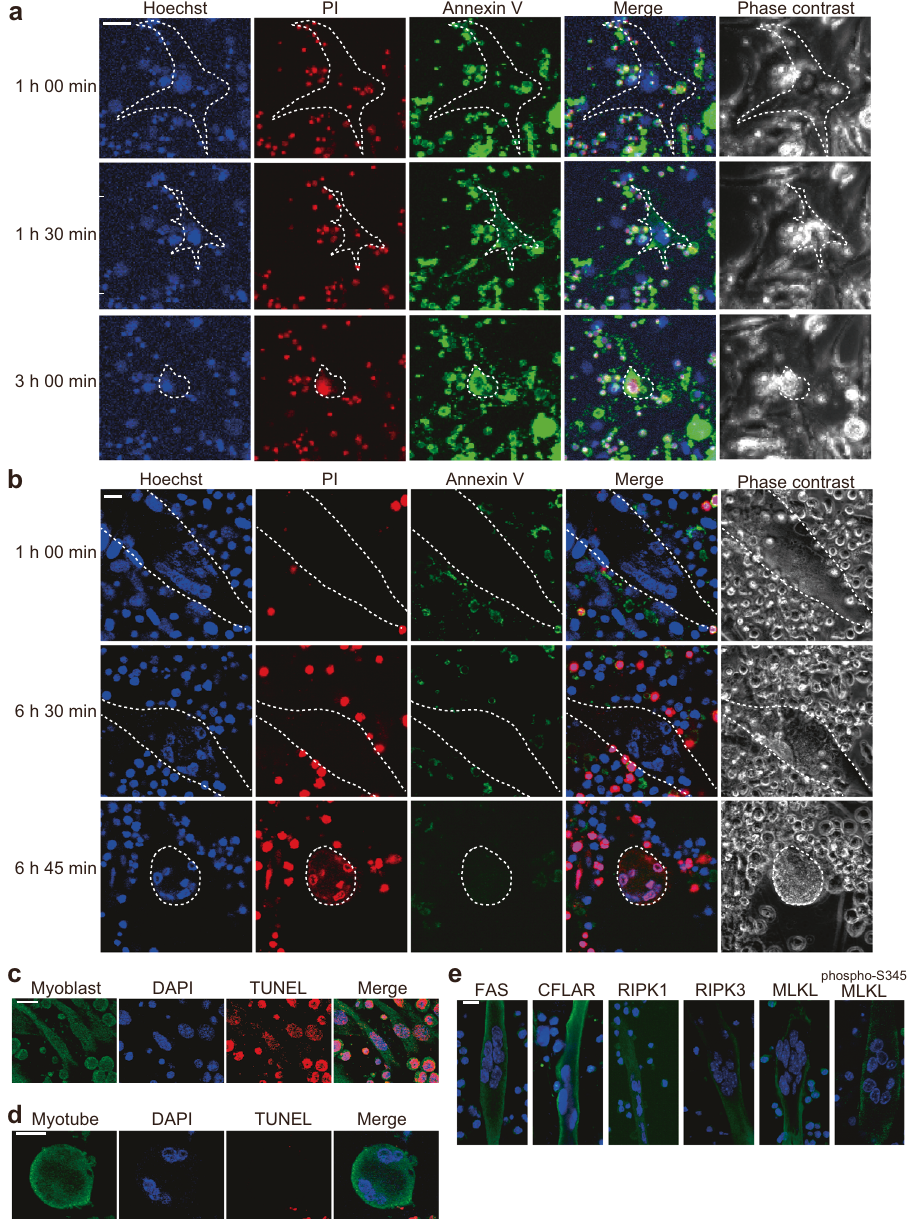
Fig. 3 Different pattern of cell death between myoblasts and myotubes in the co-culture with CTLs. a , b The representative confocal z-stack images of time-lapse analysis of H2K b OVA-myoblasts ( a ) or H2K b OVA-myotubes ( b ) co-cultured with OT-I CTLs in the presence of Annexin V (green) and PI (red). Nuclei of the cells were stained with Hoechst 33342 (blue). Images were taken at the indicated times from the starting of the co-culture. The cells surrounded by dotted line indicate dying myoblast and myotube. Scale bars indicate 20 μ m. Representative data of three independent experiments are shown. c , d The TUNEL staining (red) of H2K b OVA-myoblasts ( c ) or H2K b OVA-myotubes ( d ) co-cultured with OT-I CTLs for 4 or 16 h, respectively. The myoblasts and myotubes were pre-labelled with CellTracker (green). Confocal z-stack images are shown. Scale bars indicate 20 μ m. Representative data of two independent experiments are shown. e The immuno fl uorescence staining of FAS, CFLAR, RIPK1, RIPK3, MLKL, and phosphorylated MLKL at S345 (phospho-S345 MLKL; green) in H2K b OVA-myotubes co-cultured with OT-I CTLs for 8 h. Nuclei were counterstained with DAPI (blue). Scale bar indicates 10 μ m. Representative data of three independent experiments are